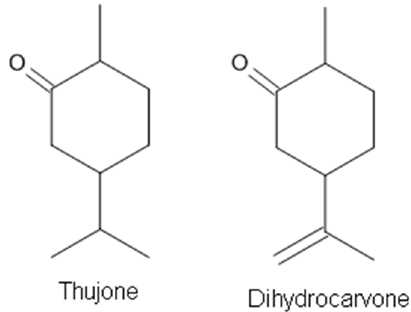
Figure 6. The terpenes acting on GABA A receptors as antagonists.